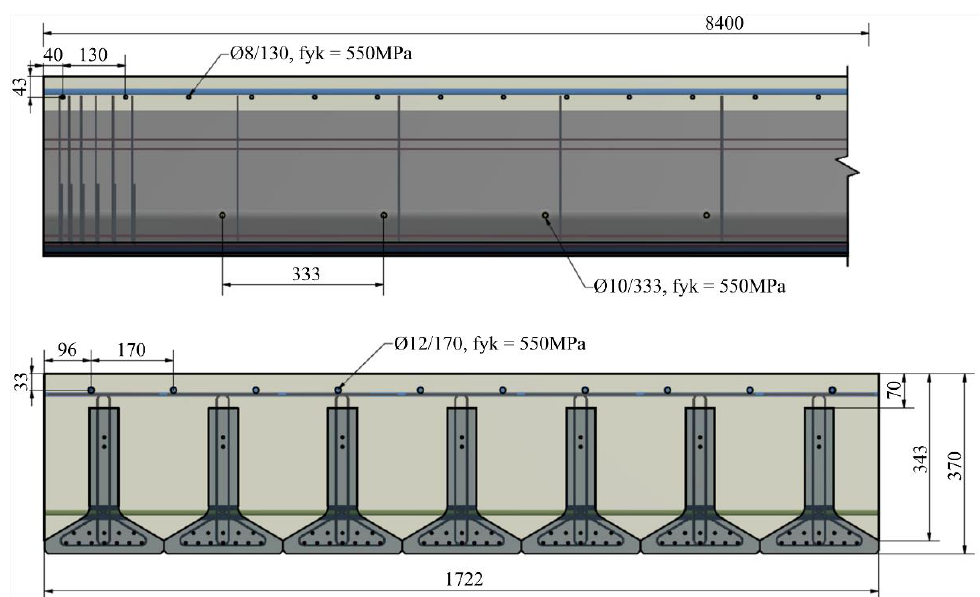
Figure 4. Drawing of down-scaled OT-slab (in top part of the figure, only left side of span is shown).